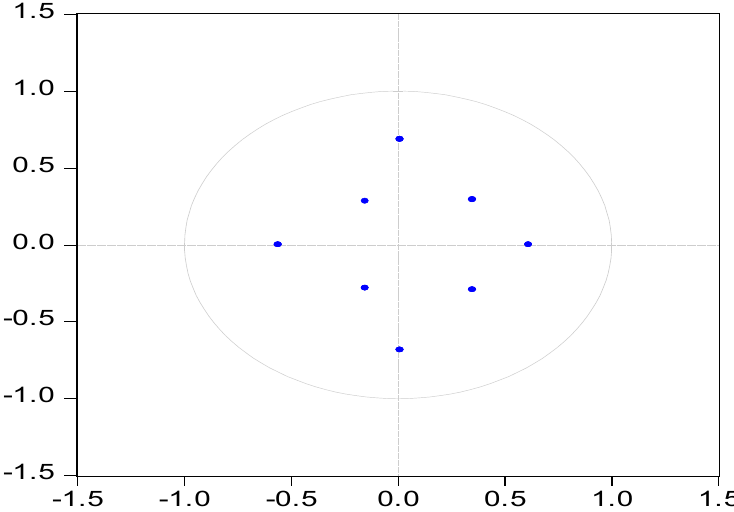
Figure 5. AR Characteristic Polynomial of the Endogenous Graph of the Crude Oil Price Shocks on GDP per Capita, and Exchange Rate in India during the period from 1990 to 2020; Source: Developed by authors. Table 4. Lag Order Selection Criteria for Crude Oil Price Shocks on GDP per Capita, and Exchange Rate in India during the period from 1990 to 2020.